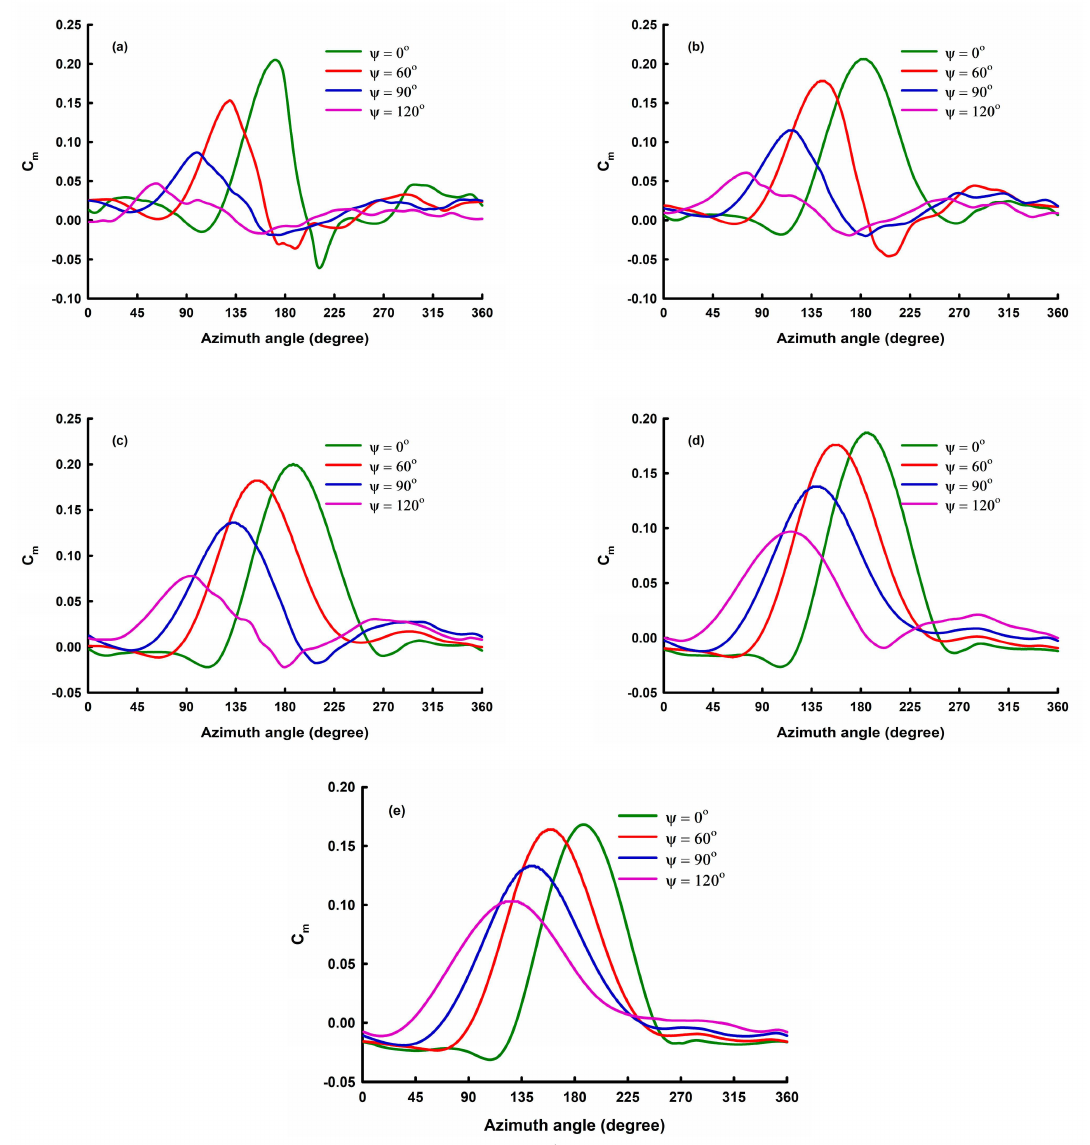
Figure 9. C m curve for the first blade of straight 60 ◦ , 90 ◦ , and 120 ◦ helix angles of blades compared at ( a ) λ = 2.3, ( b ) λ = 2.7, ( c ) λ = 3.1, ( d ) λ = 3.5, and ( e ) λ =